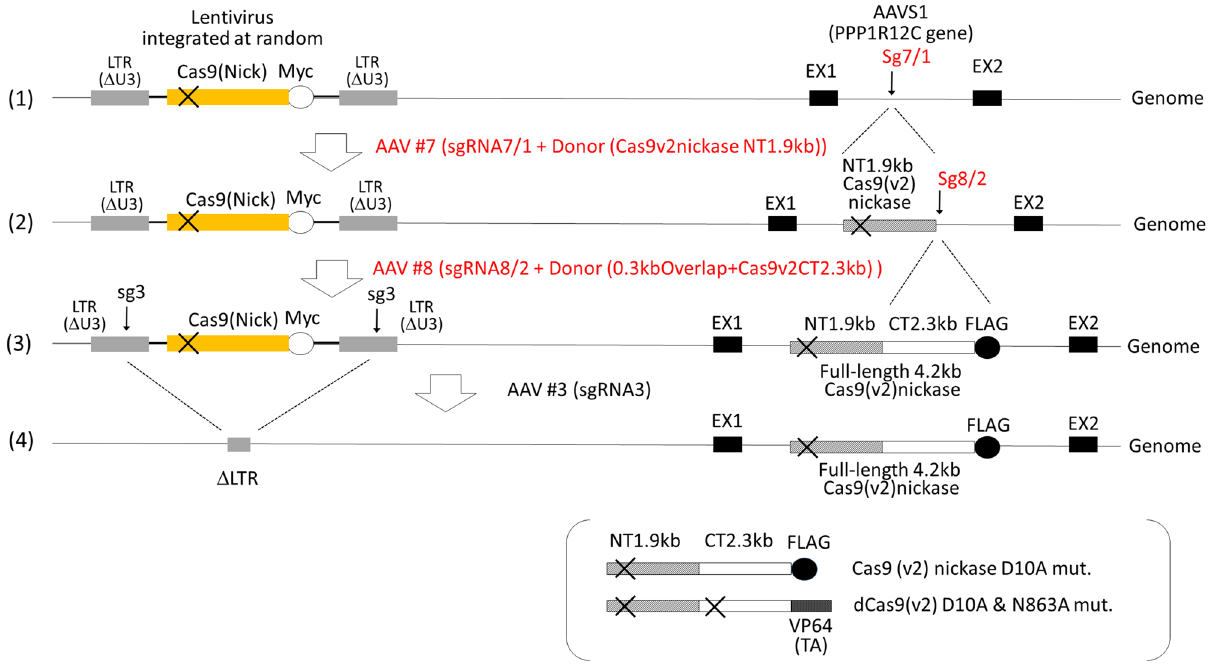
Figure 7. Schematic diagram of the four-step strategy using Lentiviral Cas9 (Nick)-Myc. (1) To reduce possible off-target effects, lentiviral Myc-tagged Cas9 nickase, termed Cas9 (Nick)-Myc (Supplementary Fig S10), was used in the first step. (2) AAV#7 (Supplementary Fig S11) was used to introduce DSB at the AAVS1 site via Cas9 (Nick)-Myc nickase. (3) AAV#8 (Supplementary Fig S12) was used to reconstitute the full-length 4.2 kb Cas9v2 nickase-FLAG. If AAV#9 (Supplementary Fig S13) was used instead of AAV#8, dead Cas9 (v2)-VP64 was produced, as shown in brackets. (4) Randomly integrated lentivirus, containing Cas9 (Nick)-Myc, was removed by AAV vector #3, with sgRNA3 targeting the long terminal repeat (LTR) of the lentivirus vector. sgRNAs targeting AAVS1, the 3 ′ -end of the 1.9 kb Cas9v1 N-terminal fragment, and the LTR of the lentivirus are shown as sg7/1, sg8/2, and sg3,